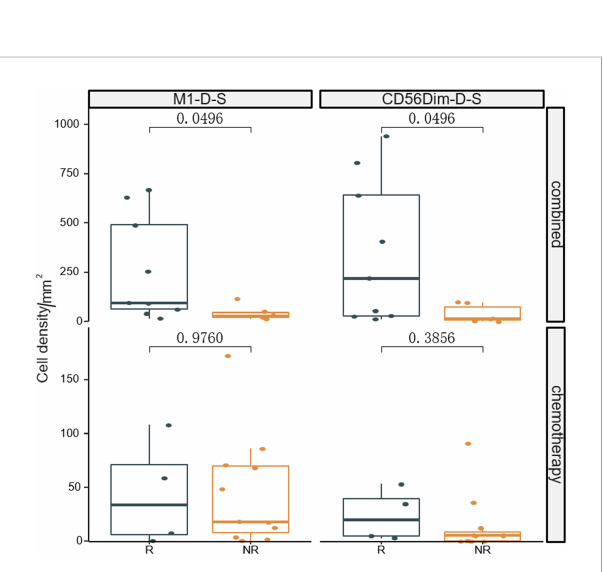
FIGURE 3 Comparison of percentages of M1 macrophages in tumor (T) and stromal (S) regions between responders and non-responders.The signi fi cance percentage of M1 macrophages from baseline between the two groups were compared. R, responder; nR, non-responder; Combined, immunochemotherapy; P, percentage; S, stroma region; T, tumor region; M1, CD68+CD163- macrophage; P < 0.05, Signi fi cant